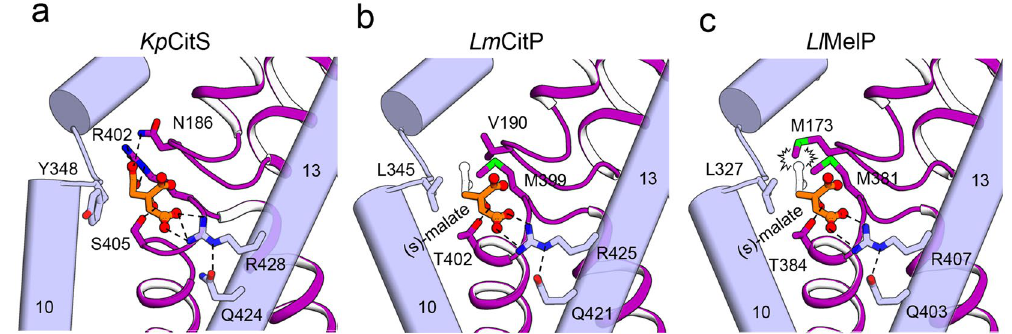
Figure 4. Homology models of Lm CitP and Ll MelP. The substrate binding sites of Kp CitS ( a ), and of homologous models of Lm CitP ( b ) and Ll MelP ( c ). Residues involved in substrate interaction are labeled. Hydrogen bonds and ionic interactions are shown by dashed lines. Backbone oxygens and nitrogens interacting with the substrate are not drawn. (S)-malates are shown as orange ball-and-stick models. The structures of the citrates superimposed on the malates are drawn as empty black sticks.